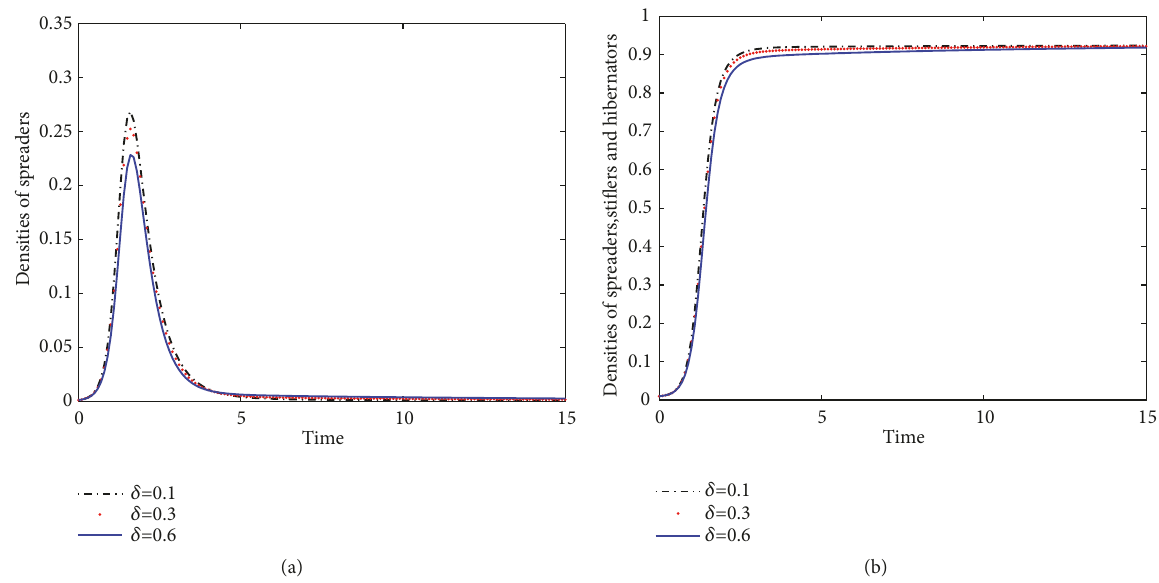
Figure 9: Numerical simulations of (3) with 𝜆 = 0.7 , 𝛽 = 0.3 , 𝛼 = 0.2 , 𝜉 = 0.1 , and 𝜂 = 0.2 and different 𝛿 in the network with the Poisson degree distribution. (a) The trajectories of the densities of spreaders. (b) The trajectories of the densities of spreaders, stiflers, and hibernators.